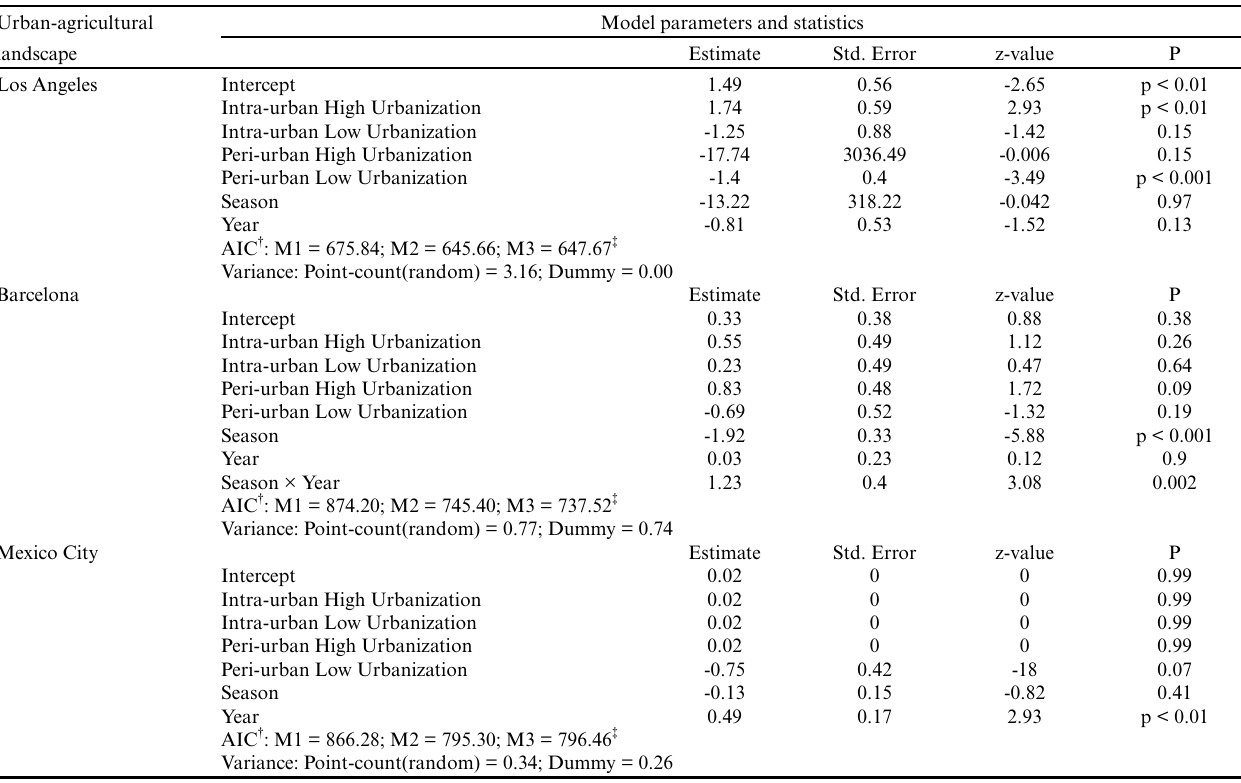
Table 3 . General linearized mixed models for House Sparrow ( Passer domesticus ) abundances in the three studied urban-agricultural landscapes. The most parsimonious model was selected based on the lowest AIC score.